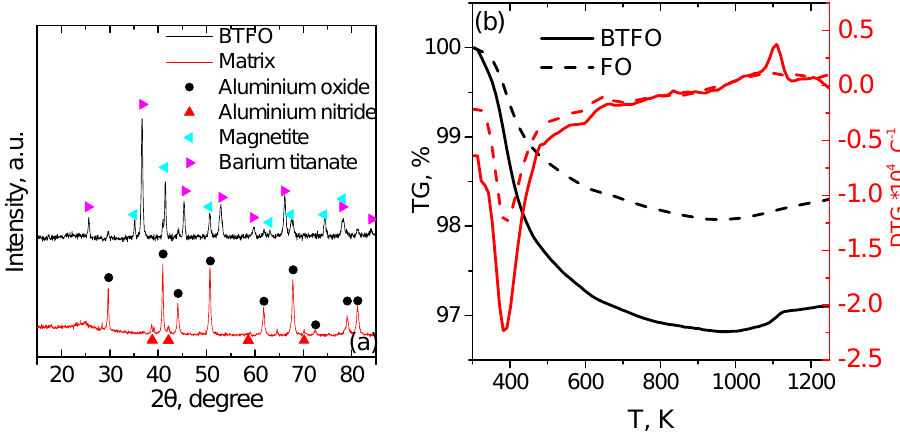
Figure 2. X-ray diffraction pattern of the BTFO and phosphate matrix ( a ). Thermogravimetric analysis of the BTFO and FO samples ( b